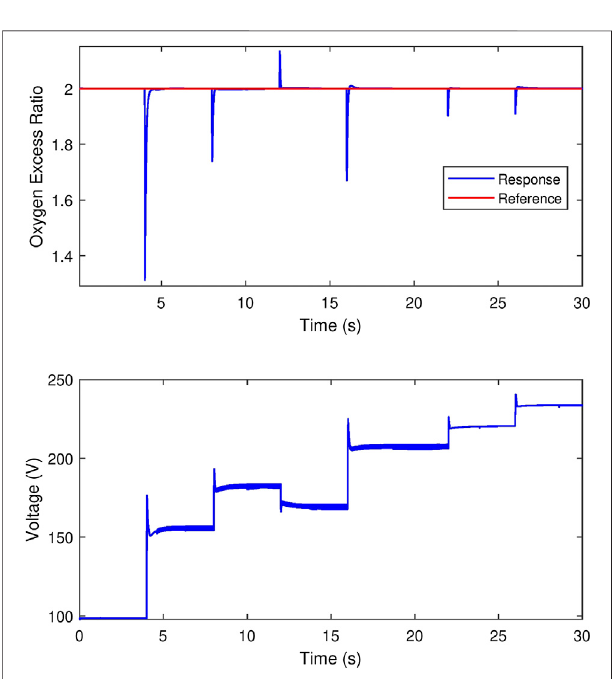
FIGURE 5 | OER regulation using GP controller for IAE